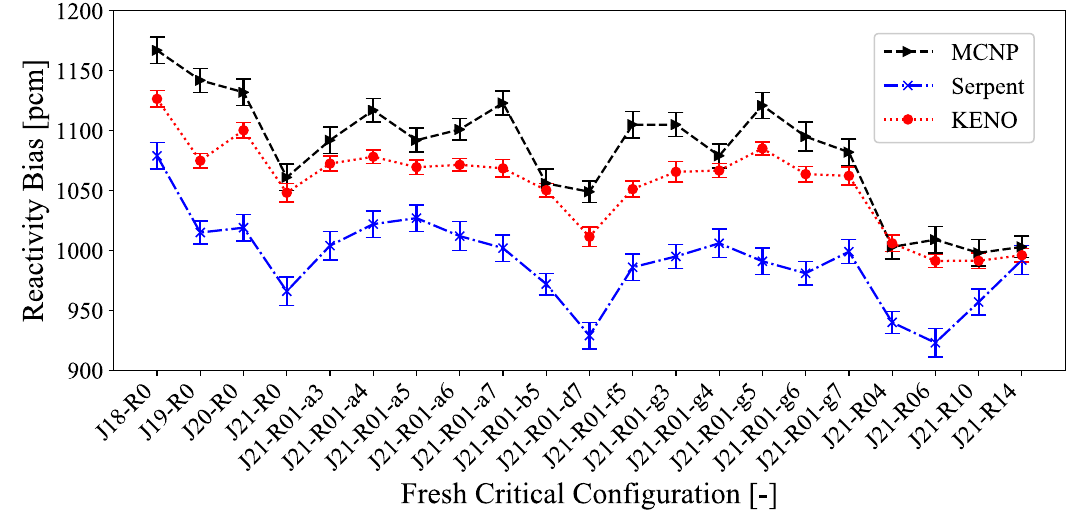
Figure 2: Comparison of MCNP6, Serpent, and KENO results for ATC experiments. Simulations were performed using MCNP6, Serpent, and KENO for each ATC configuration using slug-averaged fuel compositions. Departures from criticality represent reactivity biases and are shown for each code and configuration in Figure 2. For the simulations, 10 6 / 10 5 / 10 6 histories per cycle, 20/200/20 inactive cycles, and 80/500/230 active cycles were used with MCNP6, Serpent, and KENO,